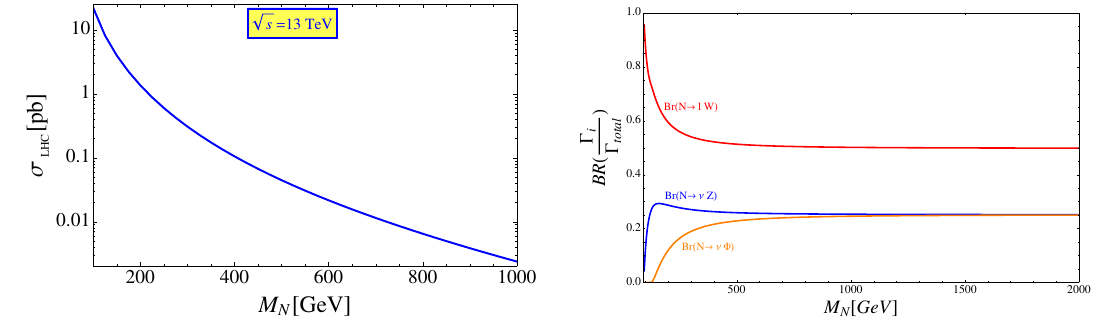
Figure 2 . (Left) The total production cross section of the heavy Majorana neutrino as a function of its mass at the LHC with p s = 13 TeV and normalised by the branching ratios ( BR i ) for di(cid:11)erent decay modes as a function of its